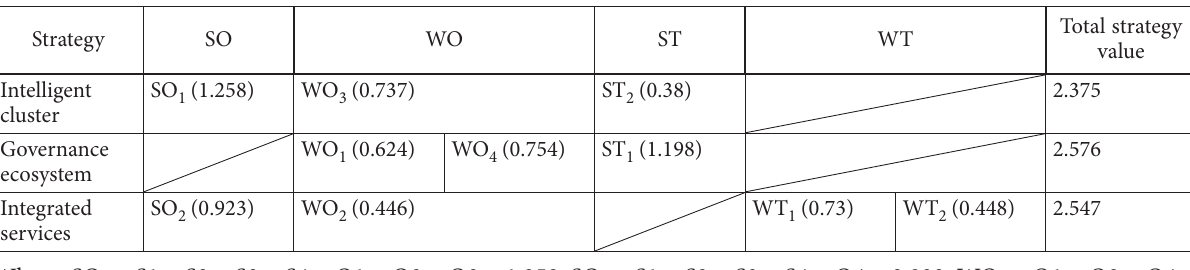
Table 6. The priorities of different strategies in developing